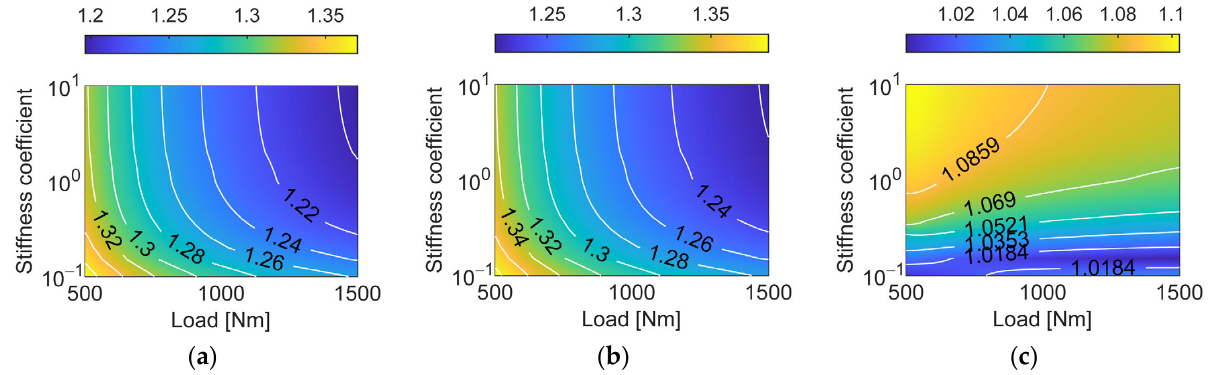
Figure 19. In fl uence of support sti ff ness of lower face gear on load-sharing coe ffi cient: ( a ) Input Gear 1; ( b ) Input Gear 2; ( c ) idler gear.